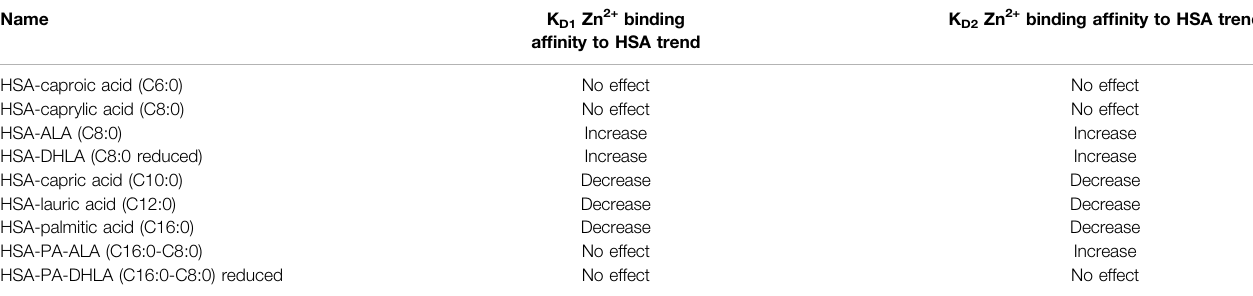
TABLE 1 | Trends of the Zn 2+ binding af fi nity to HSA in the presence of various fatty acids based on the obtained K D values of ZnCl 2 titration.